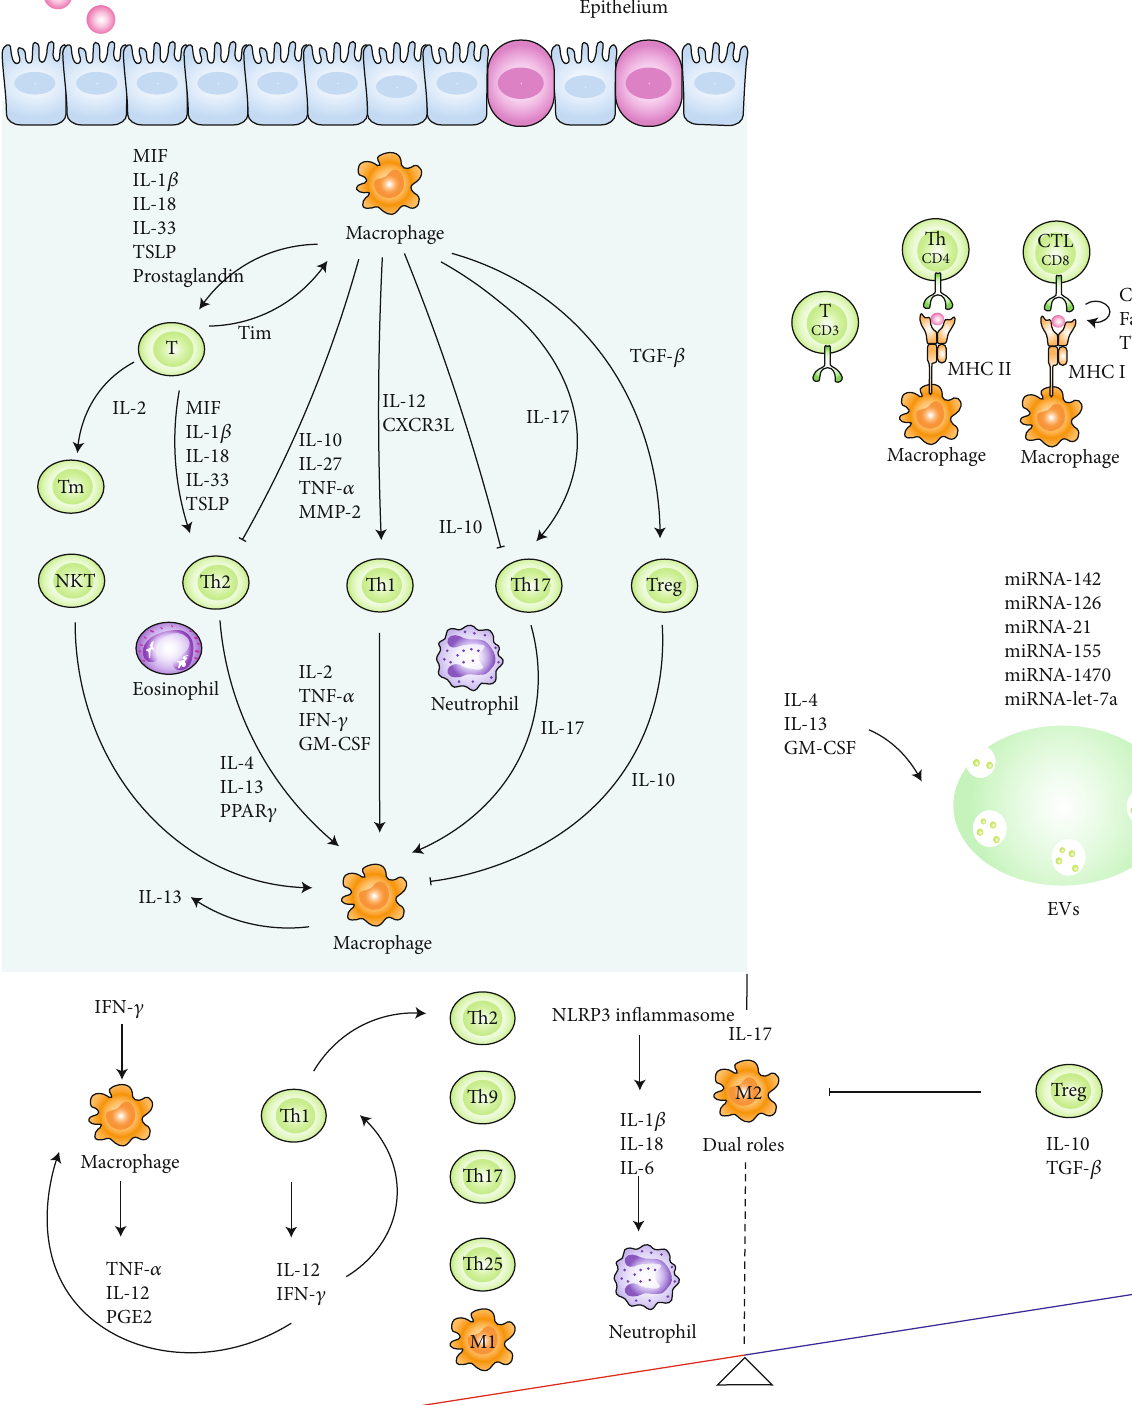
Figure 3: Crosstalk between T cells and macrophages in asthma pathogenesis. The arrows represent the cytokines secreted by T cells and macrophages. Macrophages secrete interleukin- (IL-) 10 to repress T helper (Th) 2 and Th17 cells. Similarly, Treg cells secrete IL-10 to inhibit macrophages. Antigen-contained major histocompatibility complex (MHC) class I or II molecules on macrophages bind to the T cell receptor (TCR) on T cells to mediate the adaptive immune response. Extracellular vesicles (EVs) carrying miRNAs (miRNA-142, miRNA-126, miRNA-21, etc.) may be the modulators of the crosstalk between T cells and macrophages. In addition, the imbalance caused by the cytokine storm may be the main cause of severe asthma. The red side refers to the positive feedback loops while the blue side refers to the negative feedback